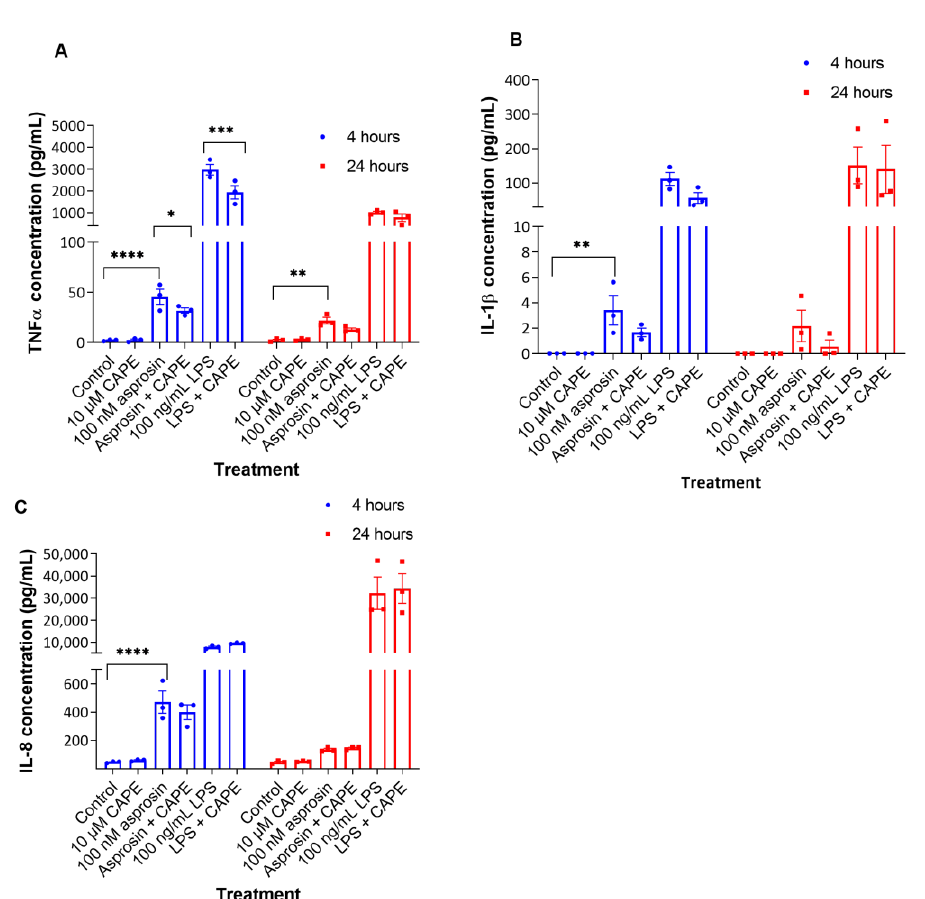
Figure 3. Asprosin-induced release of tumour necrosis factor α (TNF α ) is partly mediated through the NF κ B pathway. THP-1 macrophages were treated with 10 µ M caffeic acid phenethyl ester (CAPE; an inhibitor of NF κ B activation), 100 nM asprosin, 10 µ M CAPE and 100 nM asprosin, 100 ng/mL lipopolysaccharide (LPS) or both 100 ng/mL LPS and 10 µ M CAPE for 4 h and 24 h. Cell supernatants were collected and ( A ) TNF α ; ( B ) Interleukin-1 β (IL-1 β ), and ( C ) IL-8 concentrations were measured by ELISA. Data were analysed by two-way ANOVA and Tukey’s multiple comparisons test. Data are presented as mean ± SEM; n = 3; * p < 0.05; ** p < 0.01; *** p < 0.001; **** p < 0.0001.